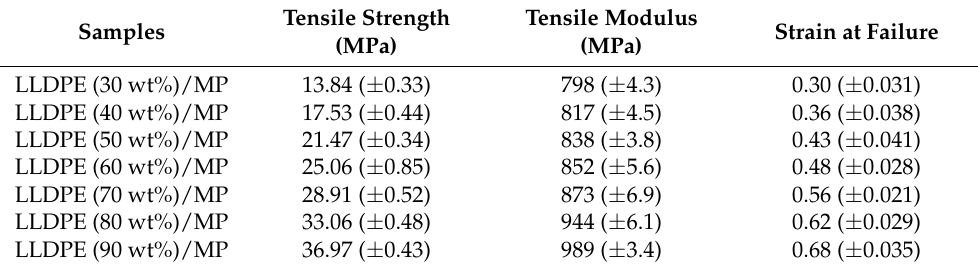
Table 2. Tensile strength, modulus, and strain to failure of LLDPE/MP fibres with different wt% LLDPE (figures in brackets represent the standard